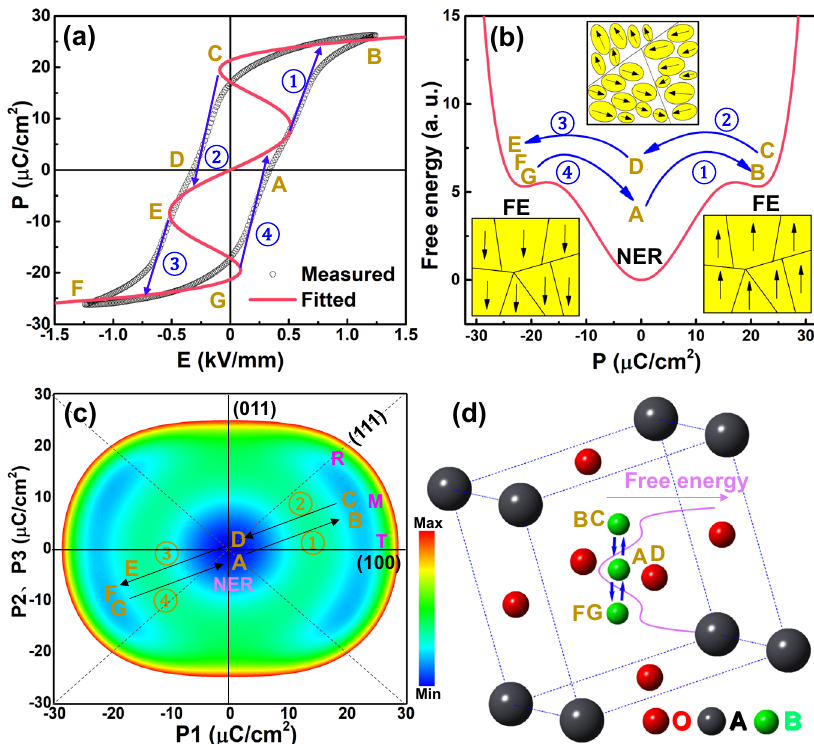
Fig. 6 | Diagram of electric fi eld-induced pseudo-ergodicity feature. a The measuredand fi tted P-E hysteresisloopsatroomtemperature. b , c TheLandaufree energypro fi lesandtheevolutionoftheschematicrepresentationofdomainsinthe